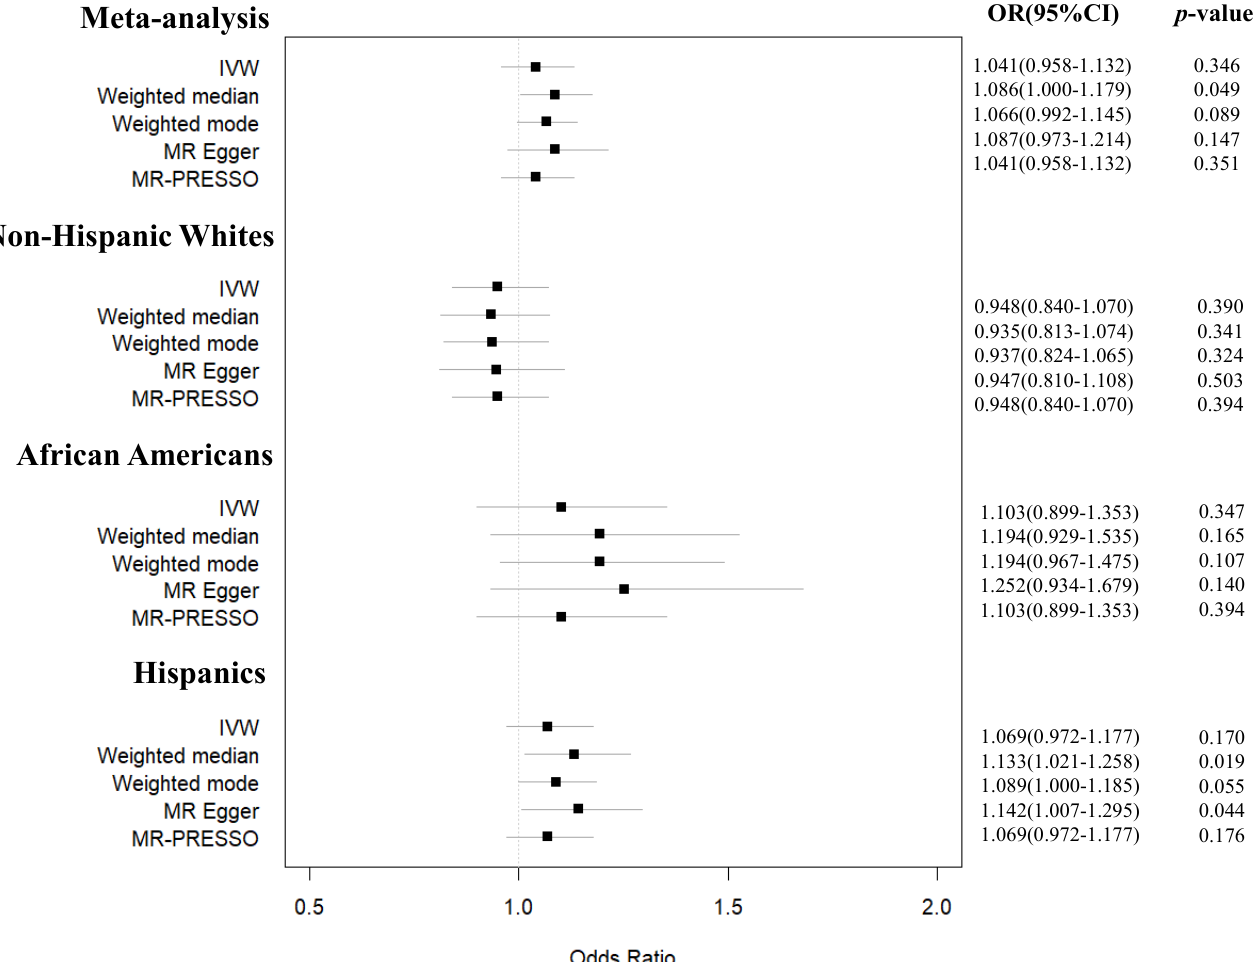
Figure 3. Forest plots with the results (in the form of MR OR for pediatric T2D per SD increase in log-transformed 25OHD) of the main MR analysis in the mixed-ancestry and ancestry-specific PRODIGY cohorts.